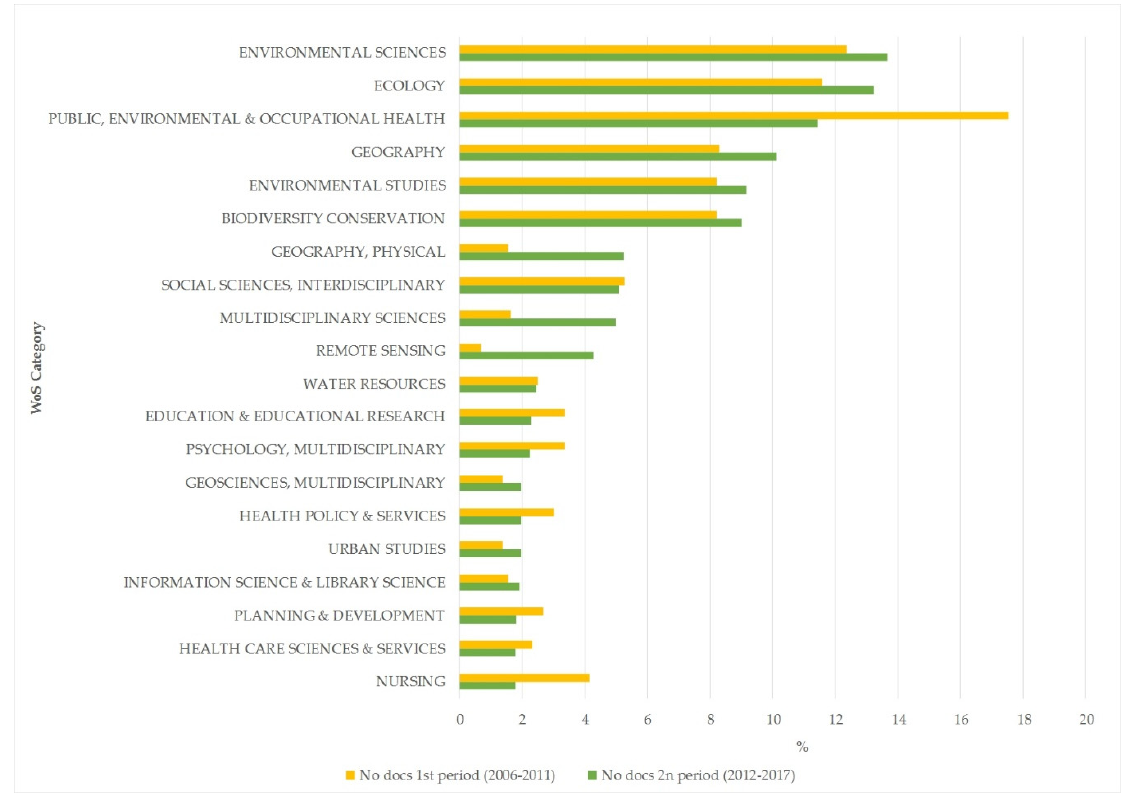
Figure 4. Distribution of output by WoS category (top 20 disciplines).